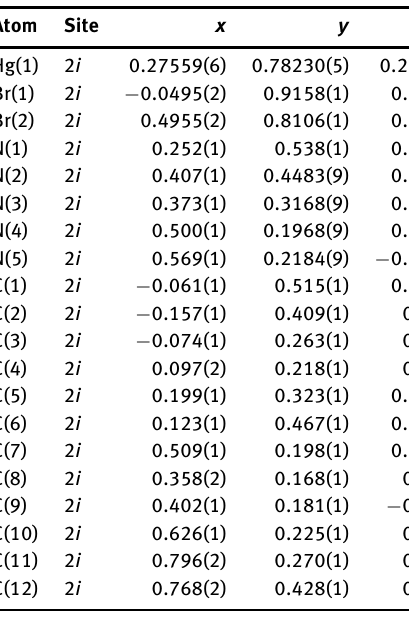
Table 3: Atomic coordinates and displacement parameters (in Å 2